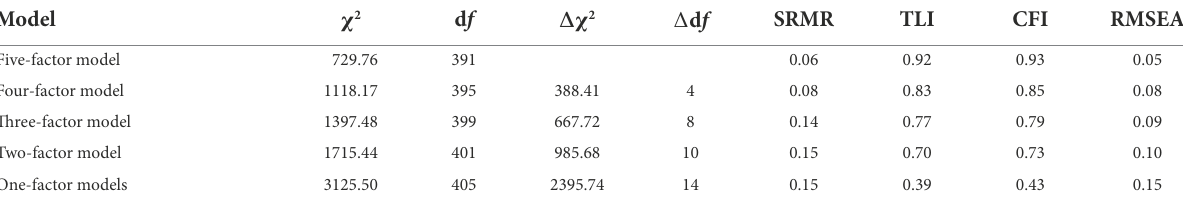
TABLE 1 The results of fit indices of confirmative factor analysis of measurements.